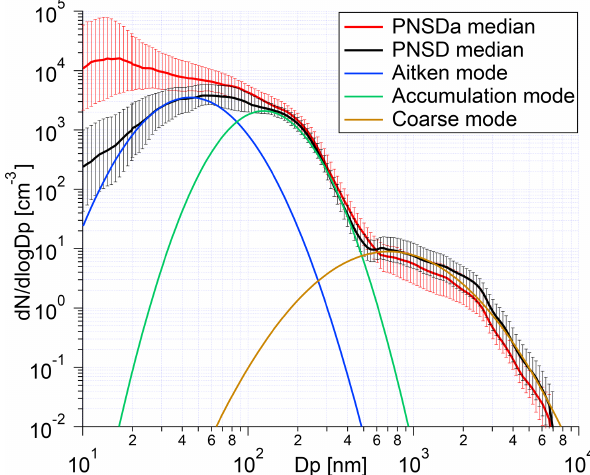
Figure 6. Comparison of the median PNSD during airport-affected (red line) and non-affected (black line) time periods. The error bar indicates the range between the 25% and 75% percentiles. Aitken, accumulation, and coarse modes are fitted with log-normal distribu- tion, displayed in blue, green, and brown lines, respectively. Table 1. Median values of N CCN , d crit , κ , and 1 standard deviation of d crit and κ at different